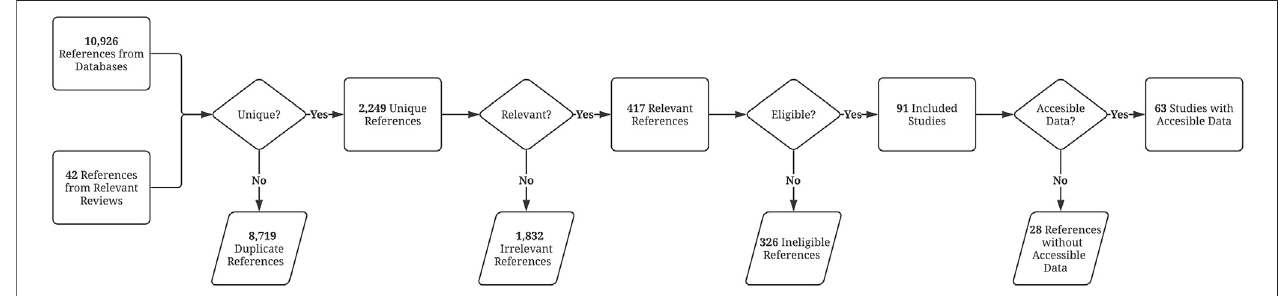
FIGURE 1 | Flowchart showing the number of studies at each stage of the selection process.